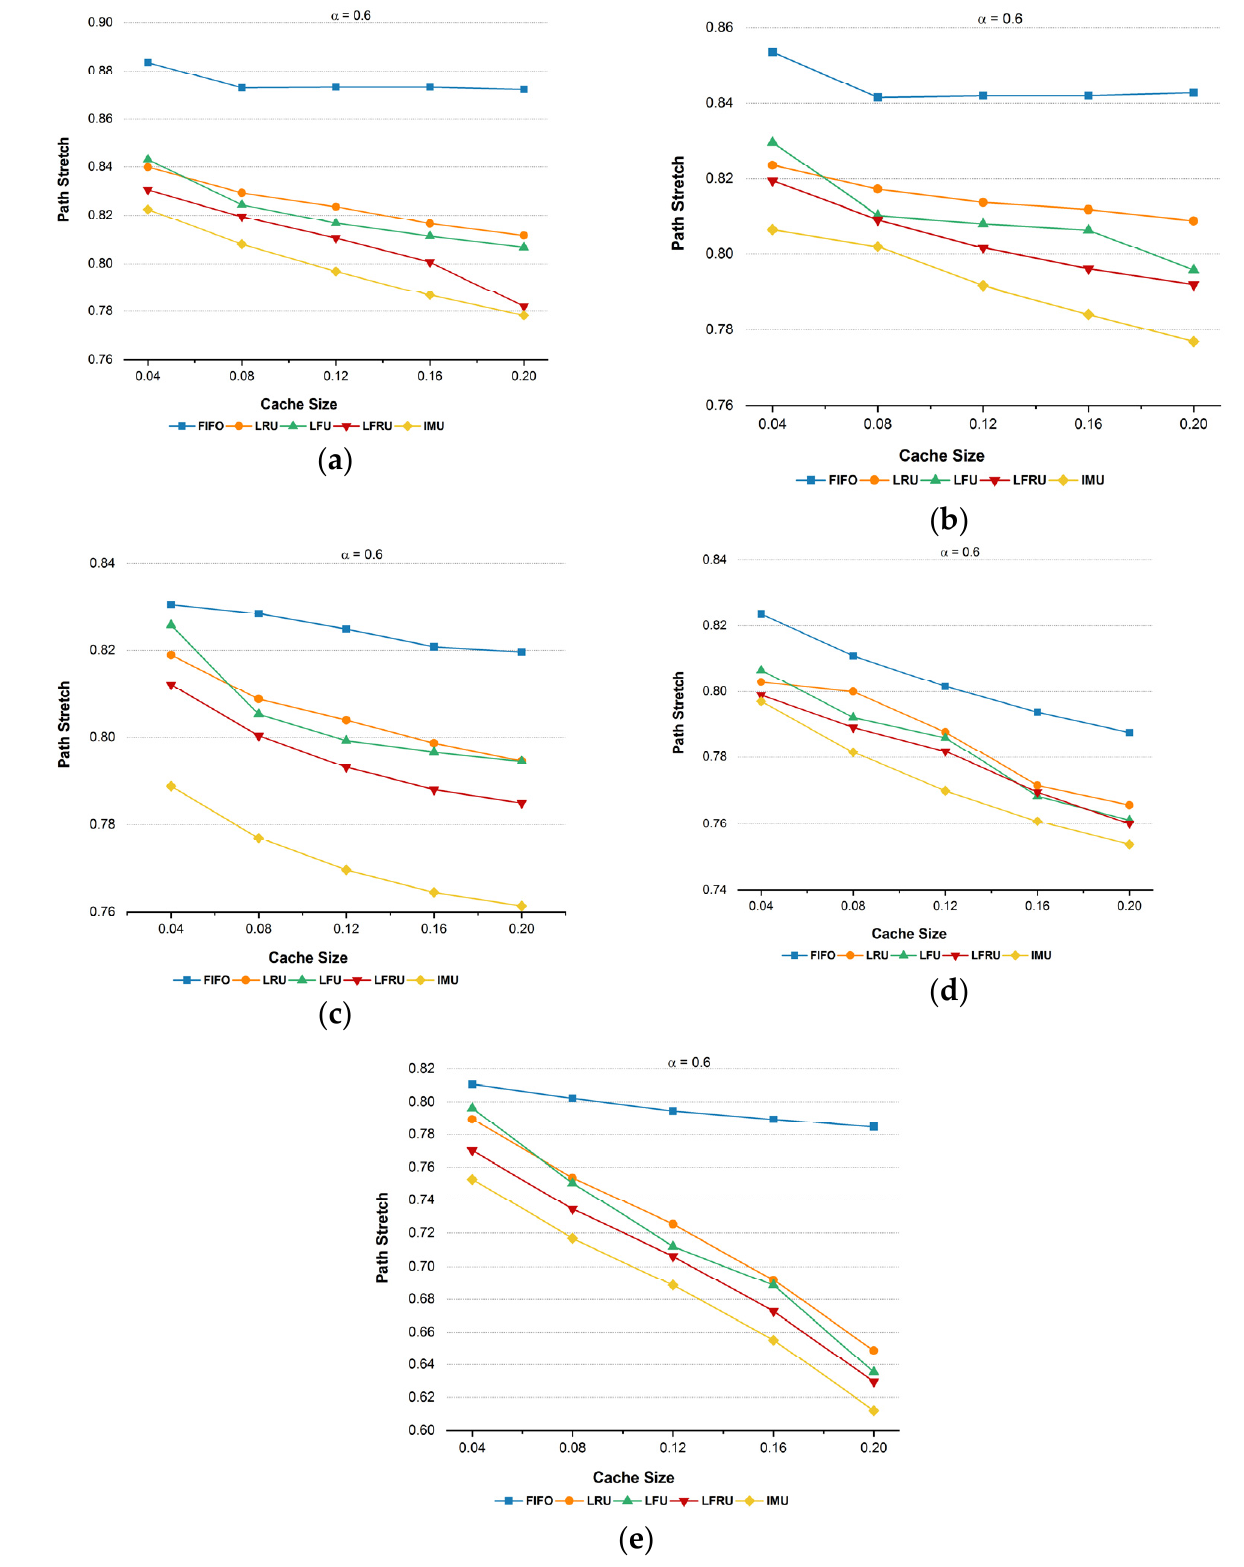
Figure 3. Path stretch with different cache sizes and α , using different placement policies. ( a ) Path stretch with LCE. ( b ) Path stretch with CL4M. ( c ) Path stretch with ProbCache. ( d ) Path stretch with LCD. ( e ) Path stretch with opt-Cache.